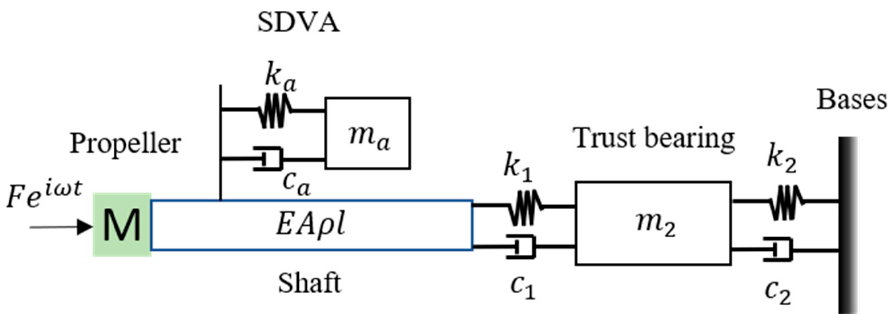
Figure 14. Simplified physical model of the propulsion shaft system with a semi-active dynamic vibration absorber [172].